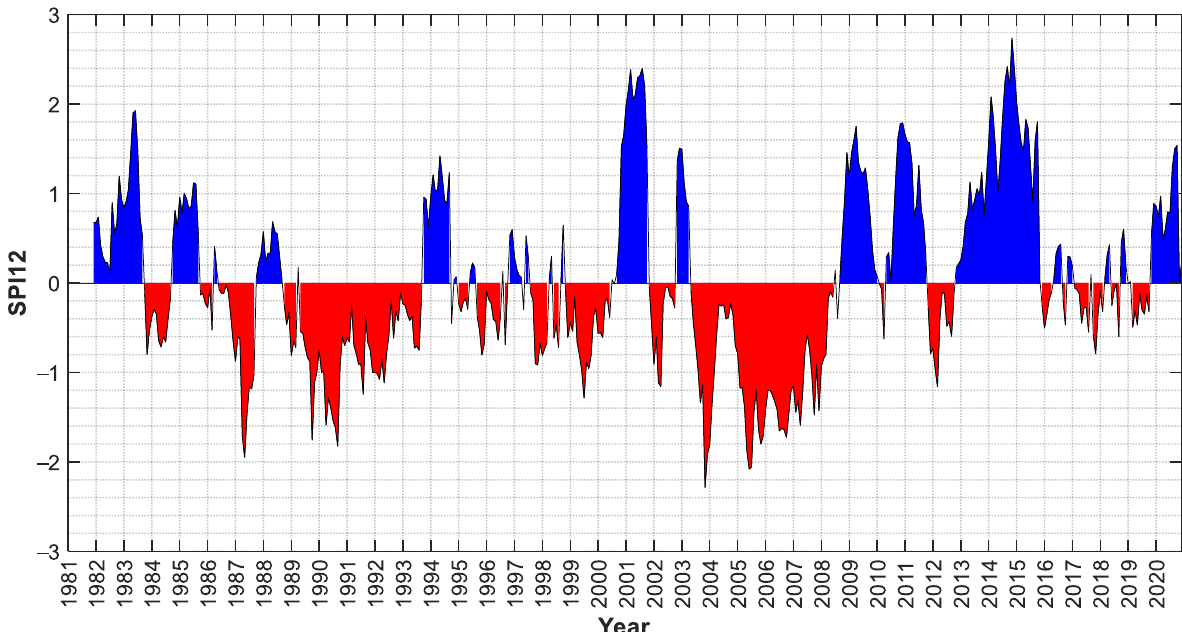
Figure 9. Reconstruction of the SPI index over 12 months by ERA5-Land reanalysis (1981–2020) for the section of the Seveso River basin closed at Bovisio-Masciago.